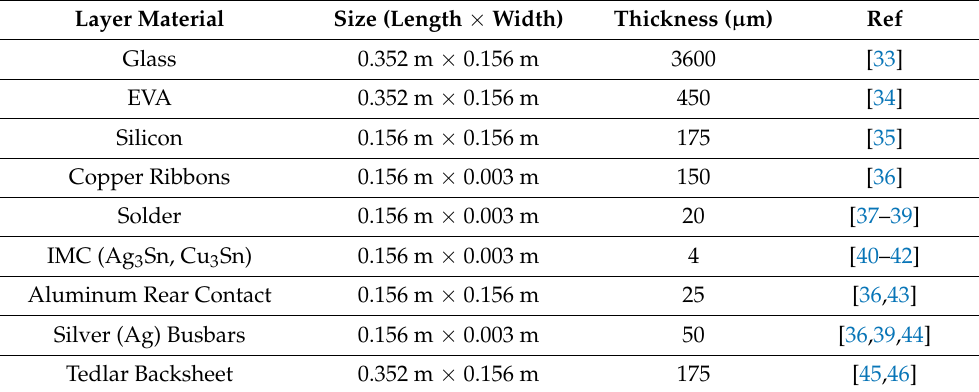
Table 3. The geometric properties of layer materials in the solar PV module.